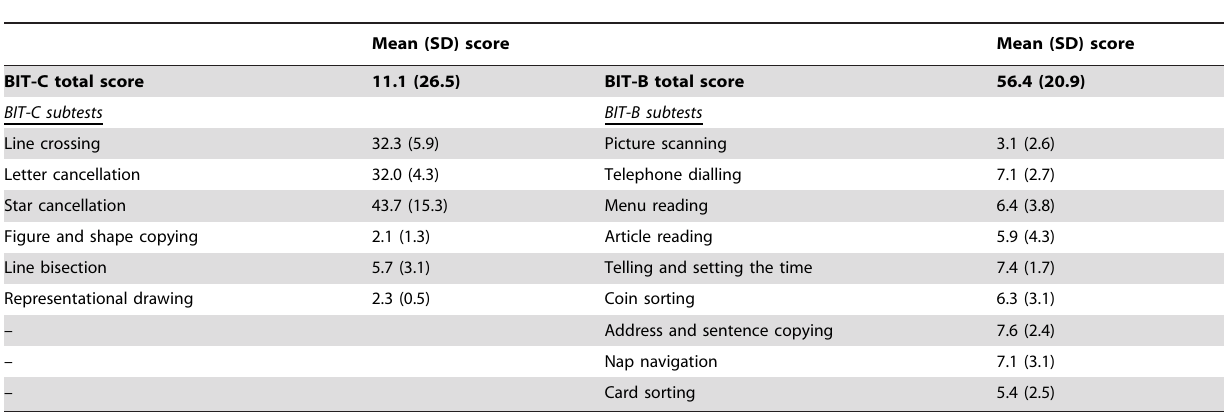
Table 1. Clinical assessment of visuospatial